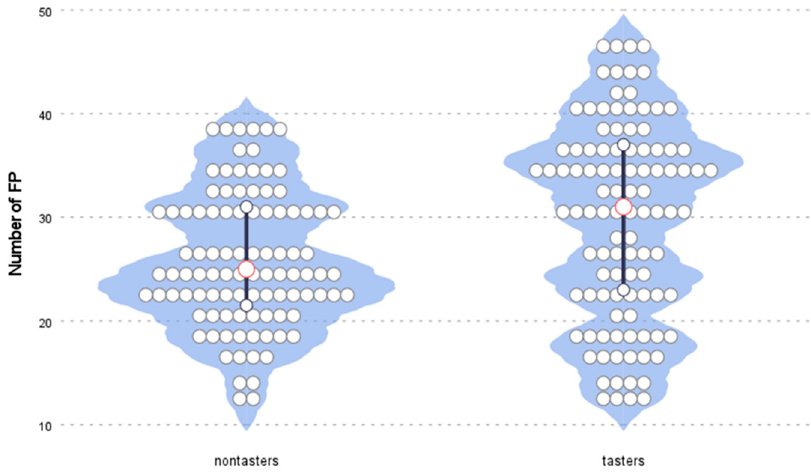
Figure 2. The distribution of the numbers of FP in the categories of tasters/nontasters.